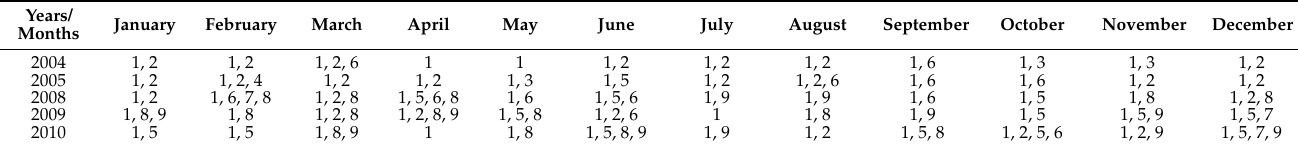
Table 3. Distribution of the meteorological systems that influenced southern Brazil during 2004, 2005, 2008, 2009, and 2010.